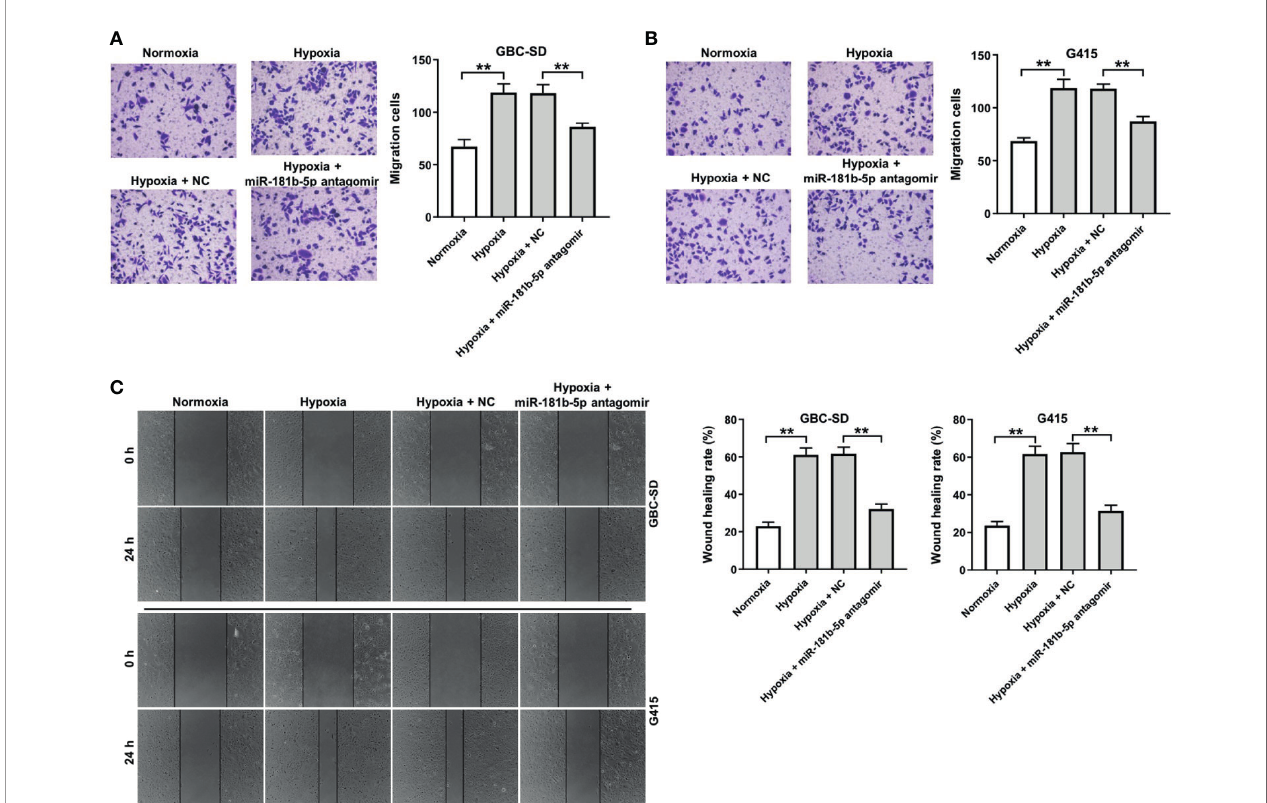
FIGURE 4 | Downregulation of miR-181b-5p inhibits the migration of GBC under hypoxia. GBC cells were treated with hypoxia or hypoxia plus miR-181-5p antagomir for 24 h (A, B) Migrated cells were stained with 0.1% crystal violet and counted at three random fi elds. (C) The ability of cell migration was detected with wound healing assay. **P < 0.01, n =